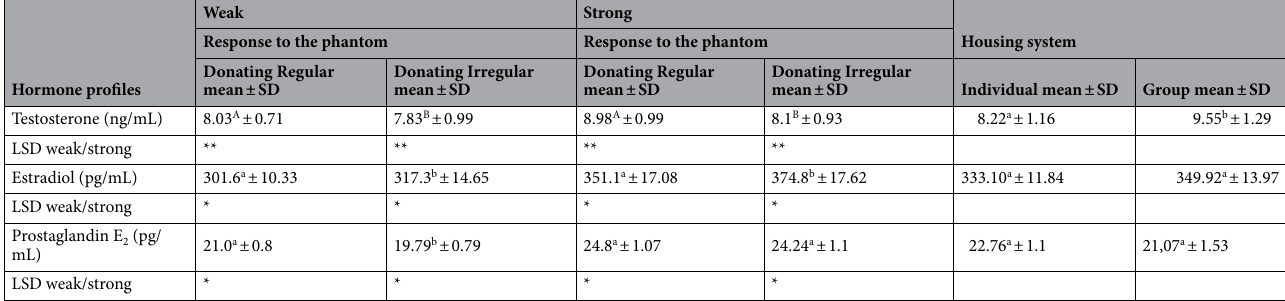
Table 3. The strength of the response to the phantom depending on the regularity of use and the concentration of hormones in the seminal plasma (mean ± SD) in connection with relationship between the male housing system and the concentration of hormones in theirseminal plasma (mean ± SD). Explanation: different letters in the same column differ significantly; a, b ( P < 0.05), C, D ( P < 0.01), * P < 0.05; ** P < 0.01. # Only animals that donate re gularly are included.